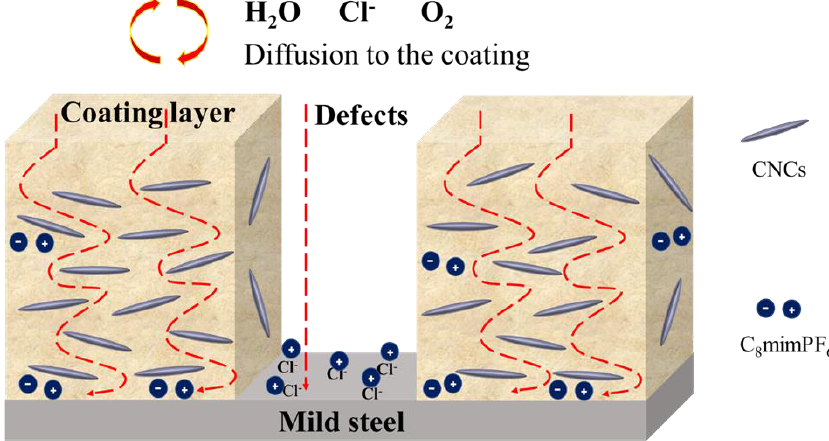
Figure 11. Schematic representation of corrosion protection for mild steel with the C 8 mimPF 6 -CNCs sample. CNCs